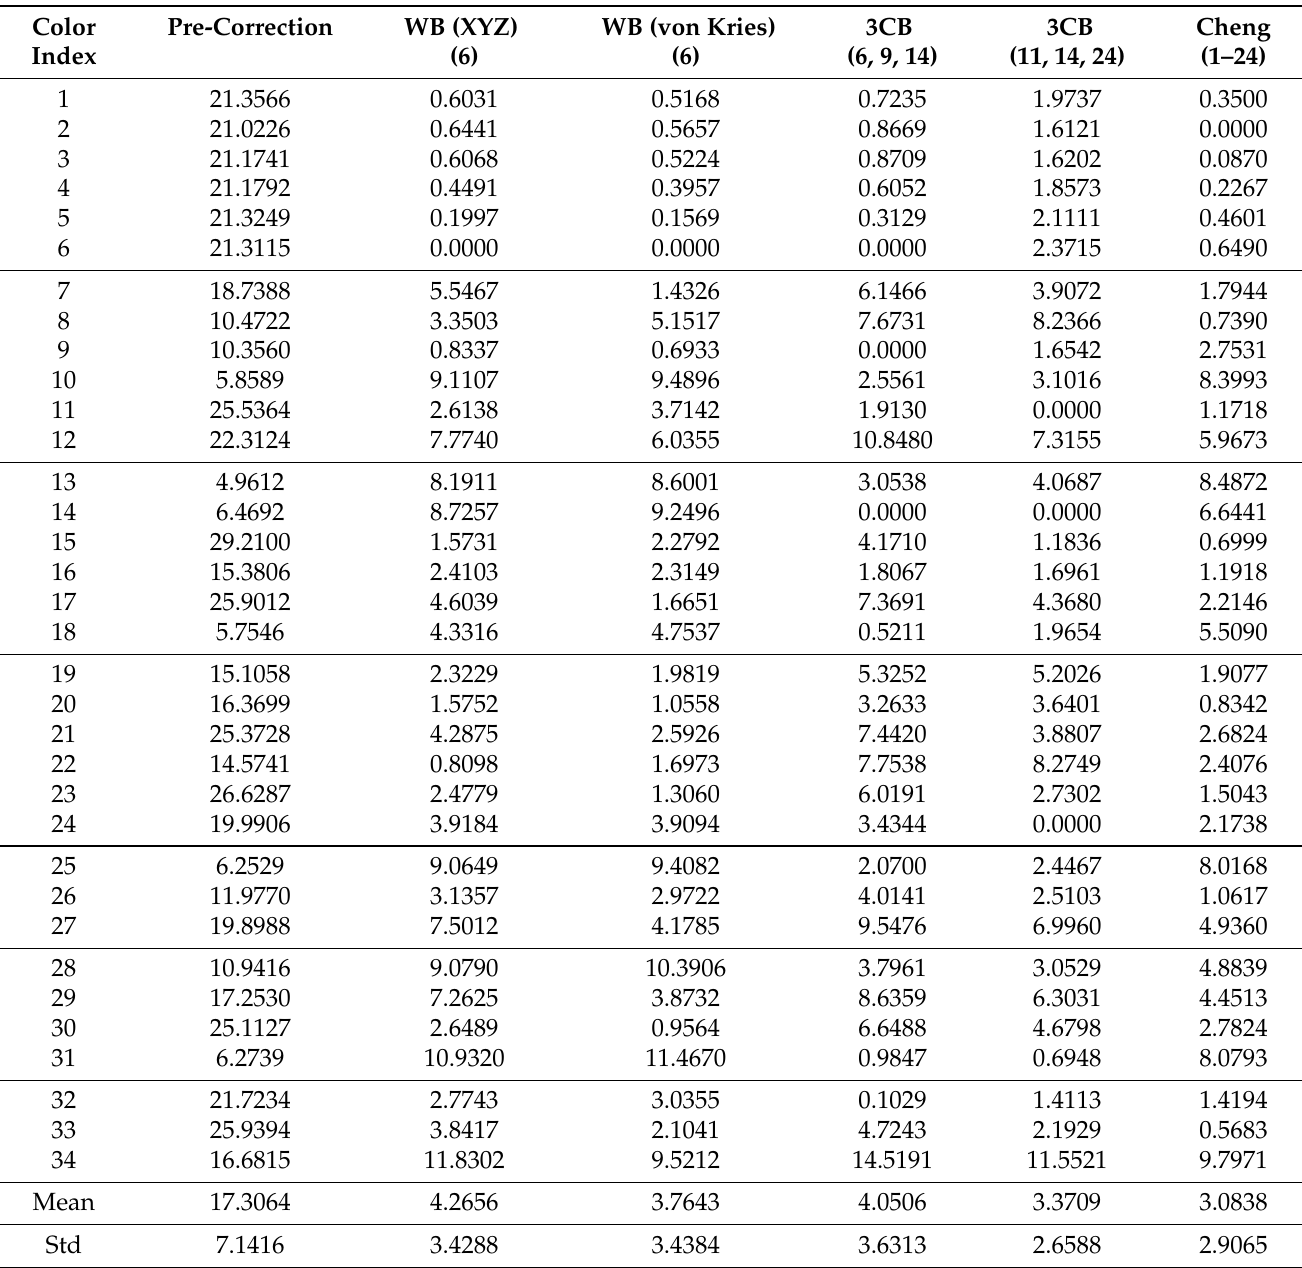
Table 2. Reproduction angular error ( Err ) for every object (deg) in Figure 7b. Color indices correspond to those in Figure 7. Indices inside () indicate target colors used in each